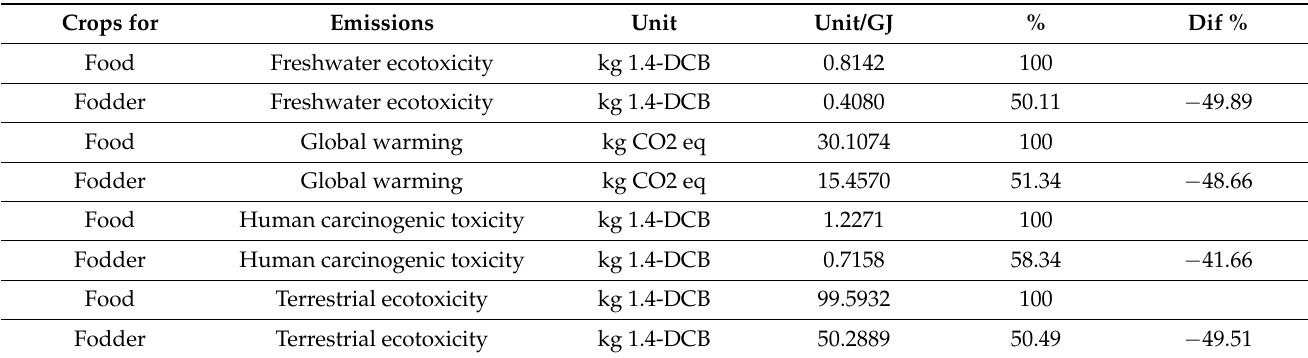
Table 1. Emissions per GJ of produced energy between crops for food and energy